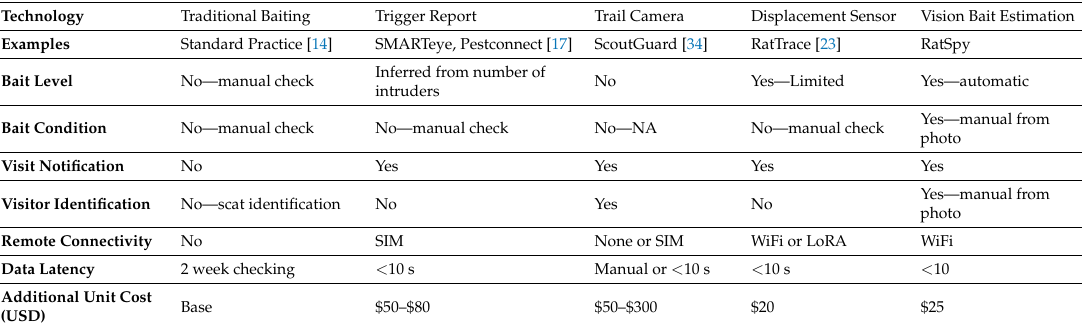
Table 4. Comparison of RatSpy to alternate monitoring systems.